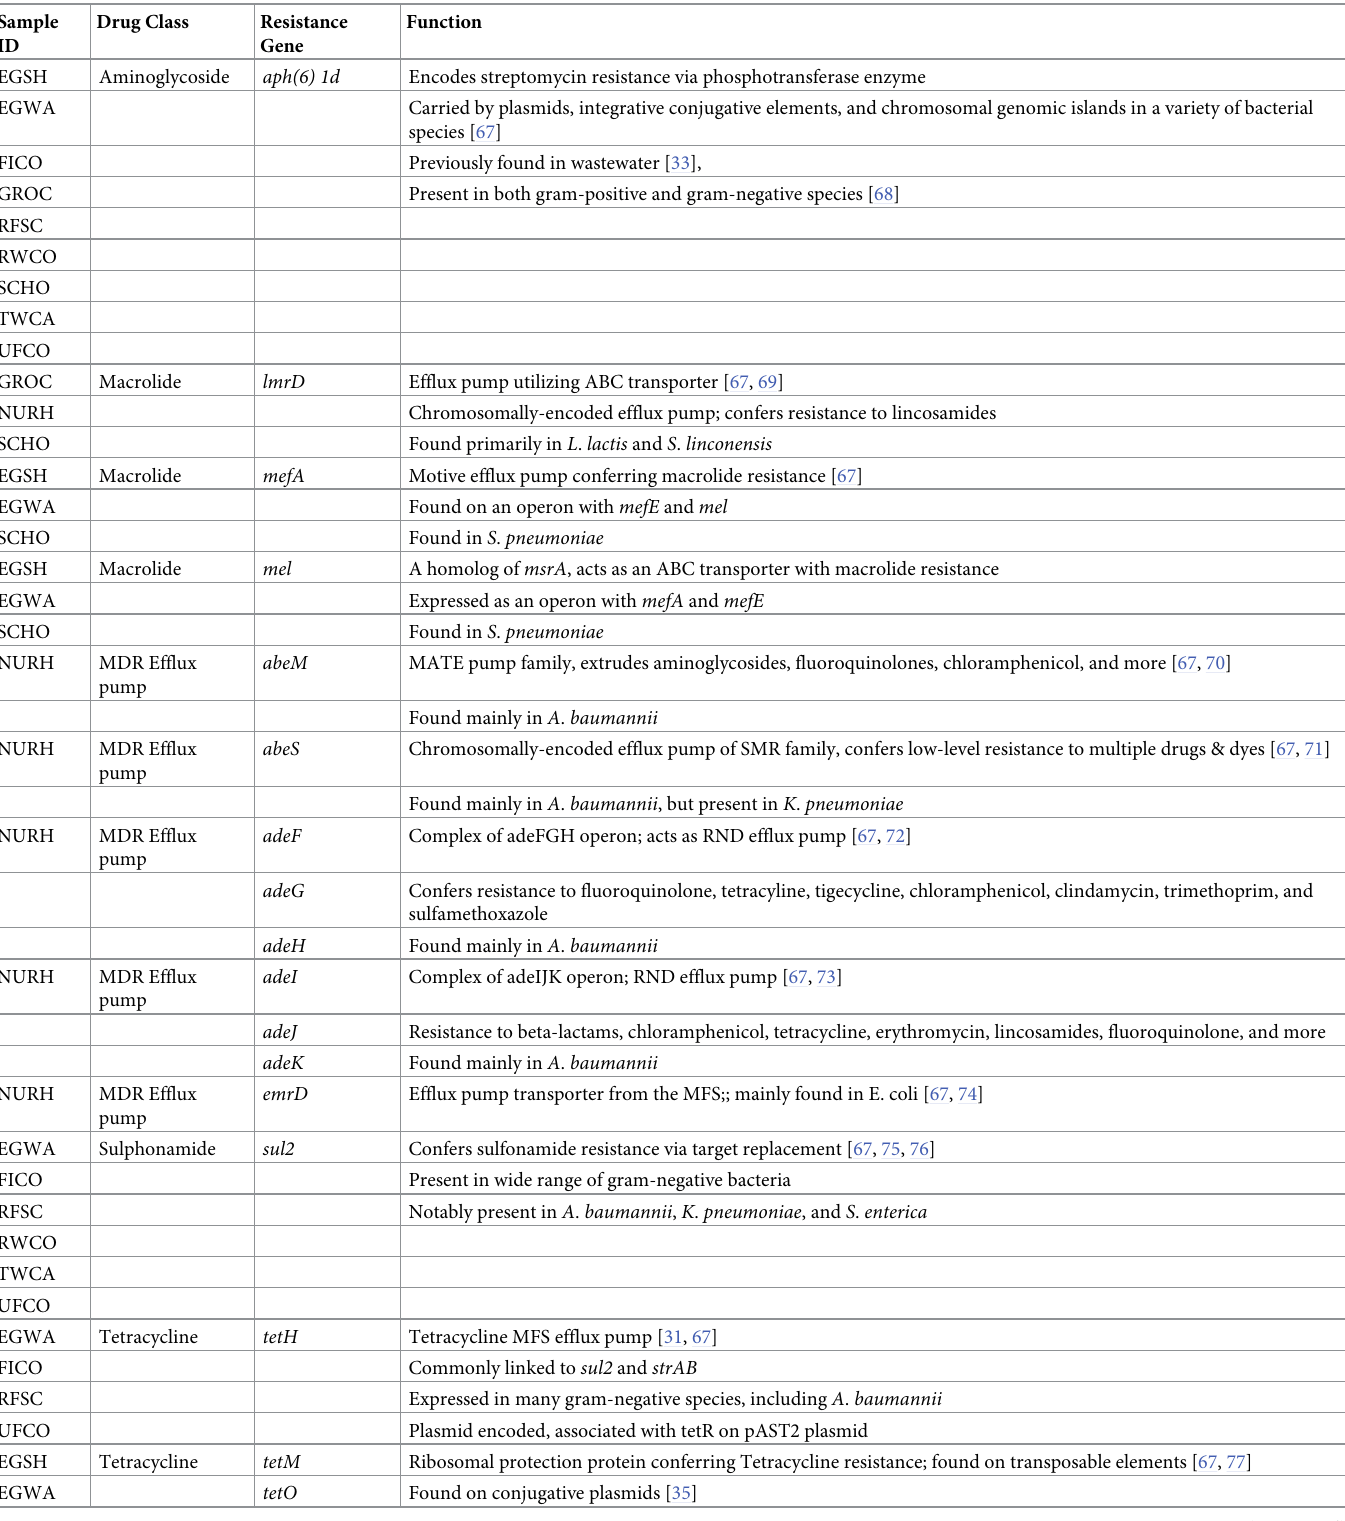
Table 2. Selected ARGs, known functions and associated